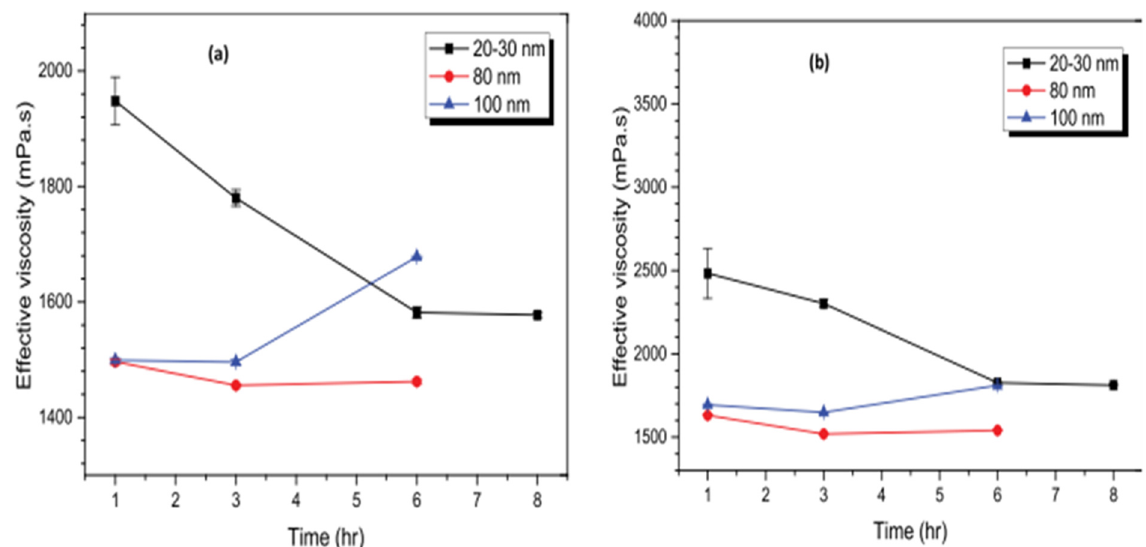
Figure 9. Influence of sonication time on viscosity of Al 2 O 3 –GL NF with volume fractions of ( a ) 2% and ( b ) 3%. Adapted from [98].